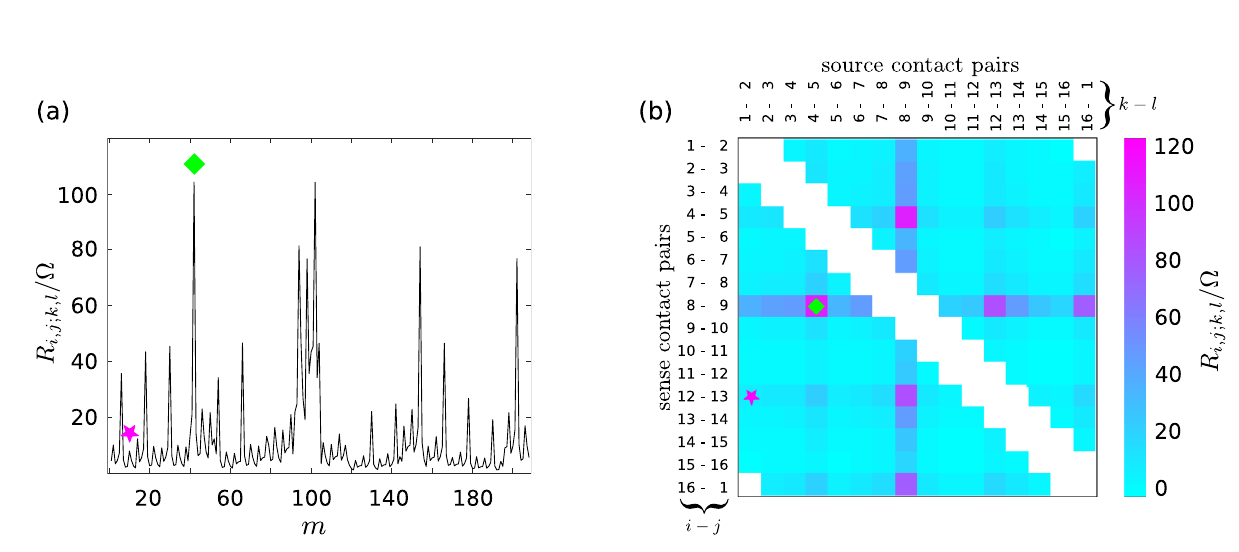
Figure 3. Representations of ERT data of the sample S . Plot of R relative to the map A in Fig. 2a. The same data represented as an impedance matrix Z ( b ). The diamond and star markers indicates the values of R i , j ; k , l measured with the corresponding contact configurations shown in the scheme in Fig. 1b. Due to the measurements arrangement in the plot ( a ), the symmetry of the data is not evident as it happens looking at Z in ( b